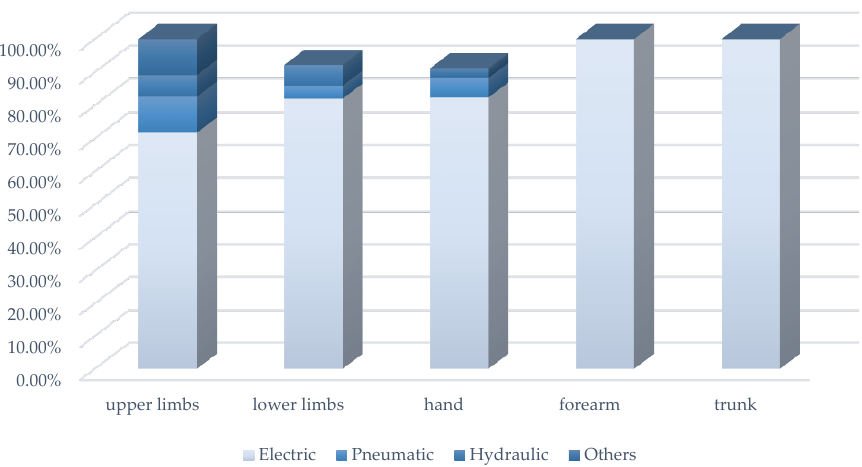
Figure 19. The distribution of power source technologies for exoskeletons dedicated to the different anatomical districts. Electric technology predominates regardless of the anatomical district to which the exoskeleton is dedicated (72% for ULE, 82% for LLE and hand exoskeletons). ULE pneumatic actuation is at 10%, and other solutions have the same percentage.